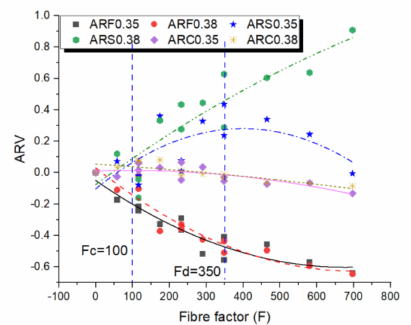
Figure 7. Influence of FF on average relative value of flowability, strength and